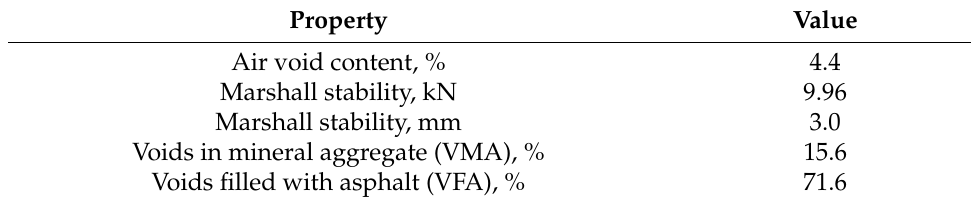
Table 2. Properties of the specimen asphalt mixture.